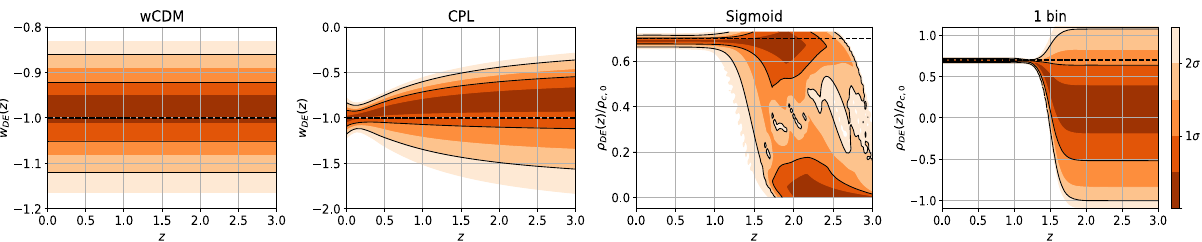
Fig. 3 These plots show the functional posterior probability: the prob- ability of w DE ( z ) or ρ DE ( z )/ρ c , 0 as normalised in each slice of constant z , with colour scale in confidence interval values. The 68% ( 1 σ) and 95% ( 2 σ) confidence intervals are plotted as black lines. From left